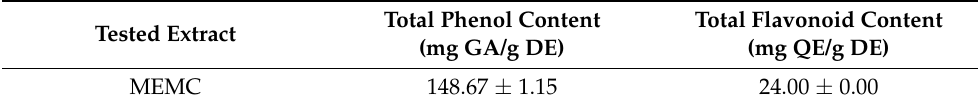
Table 2. Total phenolic and flavonoid contents of methanol leaf extract of Molineria capitulata (MEMC).